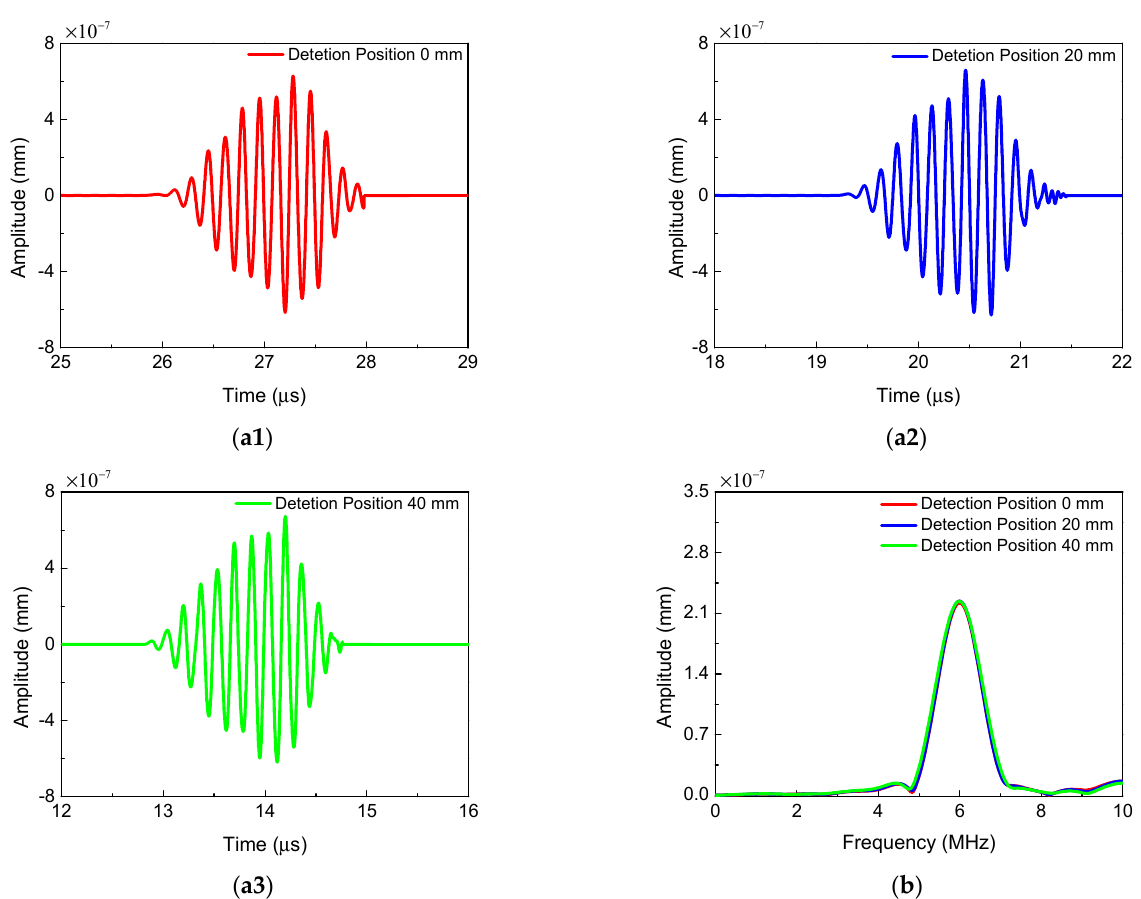
Figure 5. The signals of the resonant waves received at three signal detection positions ( c = 0.009375, f R = 6 MHz, μ = 0, L 1 = 40 mm, L 2 = 4 mm, L 3 = 36 mm). ( a1 – a3 ) Time-domain; ( b ) frequency-domain.